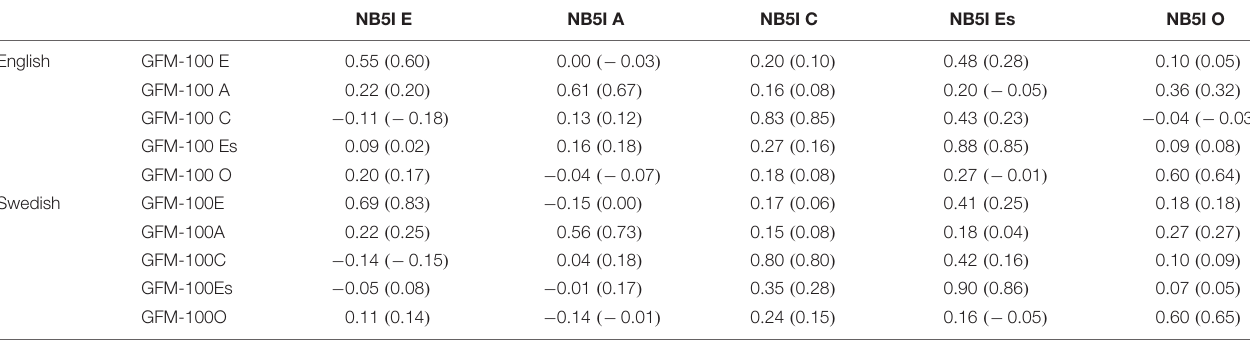
TABLE 3 | Convergent validity: Univariate correlations between the factor scales of NB5I English/Swedish and GFM-100 Eval, and partial correlations with control for evaluative factor.